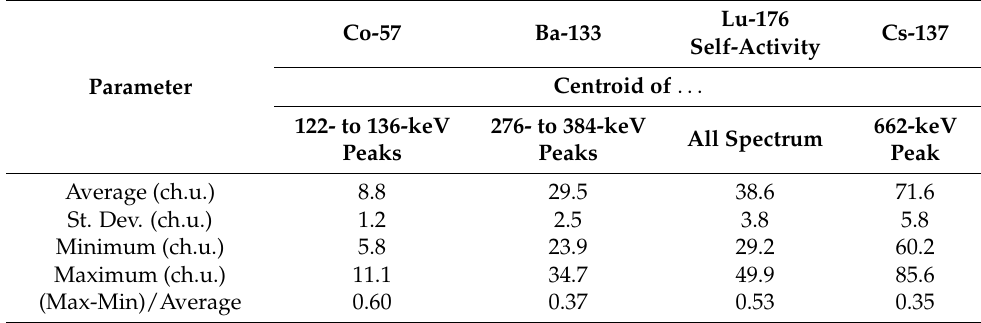
Table 1. Statistics of pulse-height pixel-values for spectra preparation.